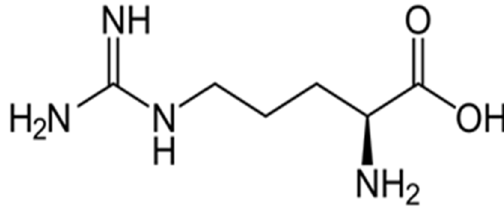
Figure 4. The chemical structure of arginine.